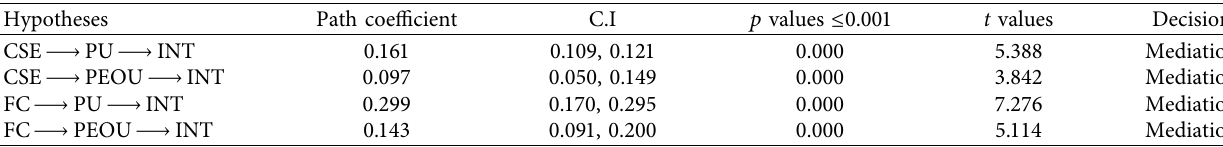
Table 6: Result of mediation